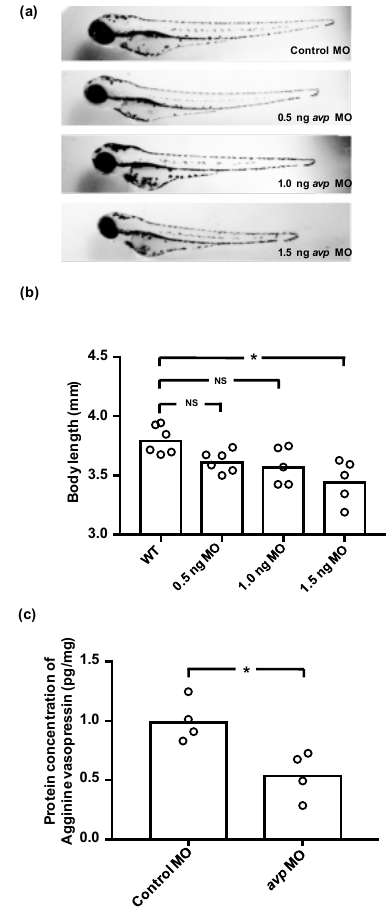
Figure 2. E ff ects of downregulating Avp by morpholino injection in zebrafish embryos. ( a ) Comparison of morphology and body length at 3 dpf for uninjected wild-type larvae (WT) and those injected with various doses of Avp morpholino (MO) at 1–2-cell stage. ( b ) Histogram shows body length with individual measurements indicated by open circles. ( c ) Relative protein level of AVP at 3 dpf was assessed by enzyme-linked immunosorbent assay (ELISA) in larvae injected with 1 ng of control morpholino or Avp morpholino (AVP MO). Asterisk indicates a significant di ff erence from uninjected wild type ( b ) or control ( c ), according to one-way ANOVA, Tukey’s pair-wise comparison, and Student’s t -test, p < 0.05. N.S. indicates not